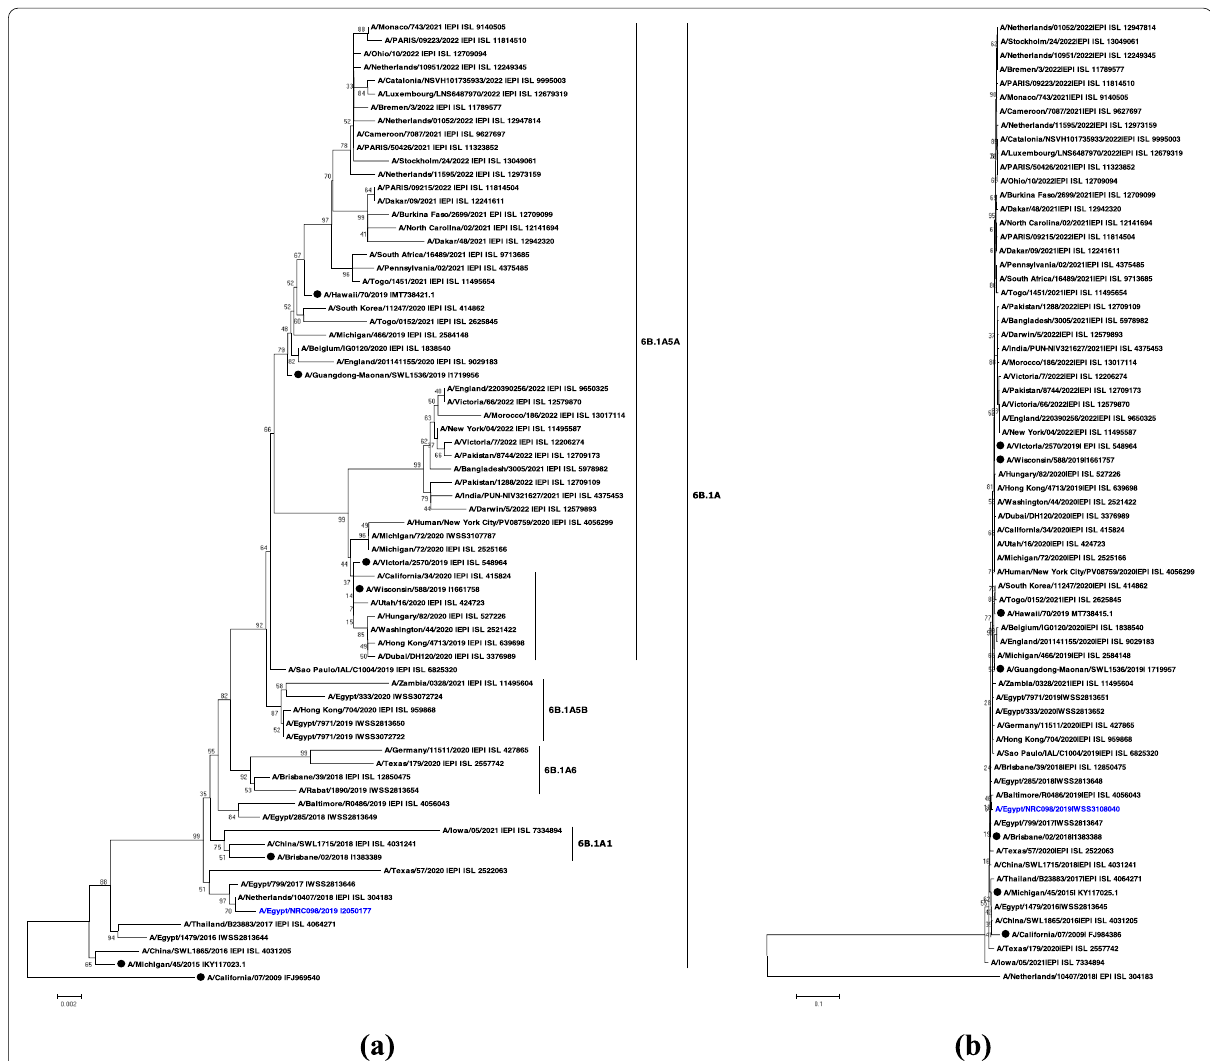
Fig. 3 Phylogenetic analysis of the full HA ( a ) and NA ( b ) genetic segments from the studied candidate influenza vaccine strain A/Egypt/ NRC098/2019 (H1N1). The tree was rooted with A/California/07/2009. Our candidate vaccine strain A/Egypt/NRC098/2019 (H1N1) is indicated in blue color. Vaccine strains A/Brisbane/02/2018 (egg-based, 2019–2020 NH influenza season), A/Guangdong-Maonan/SWL1536/2019